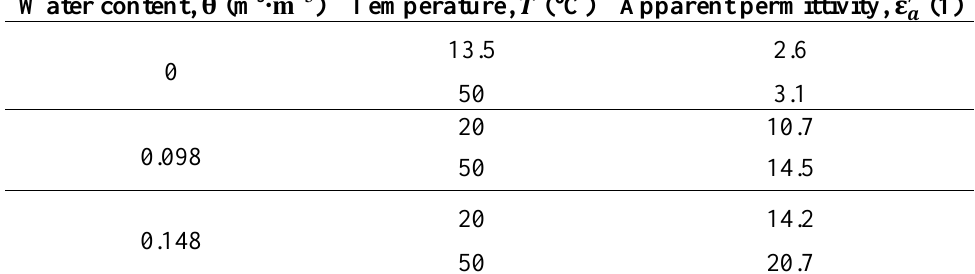
Table 3. Variation of with temperature at three volumetric water contents with the